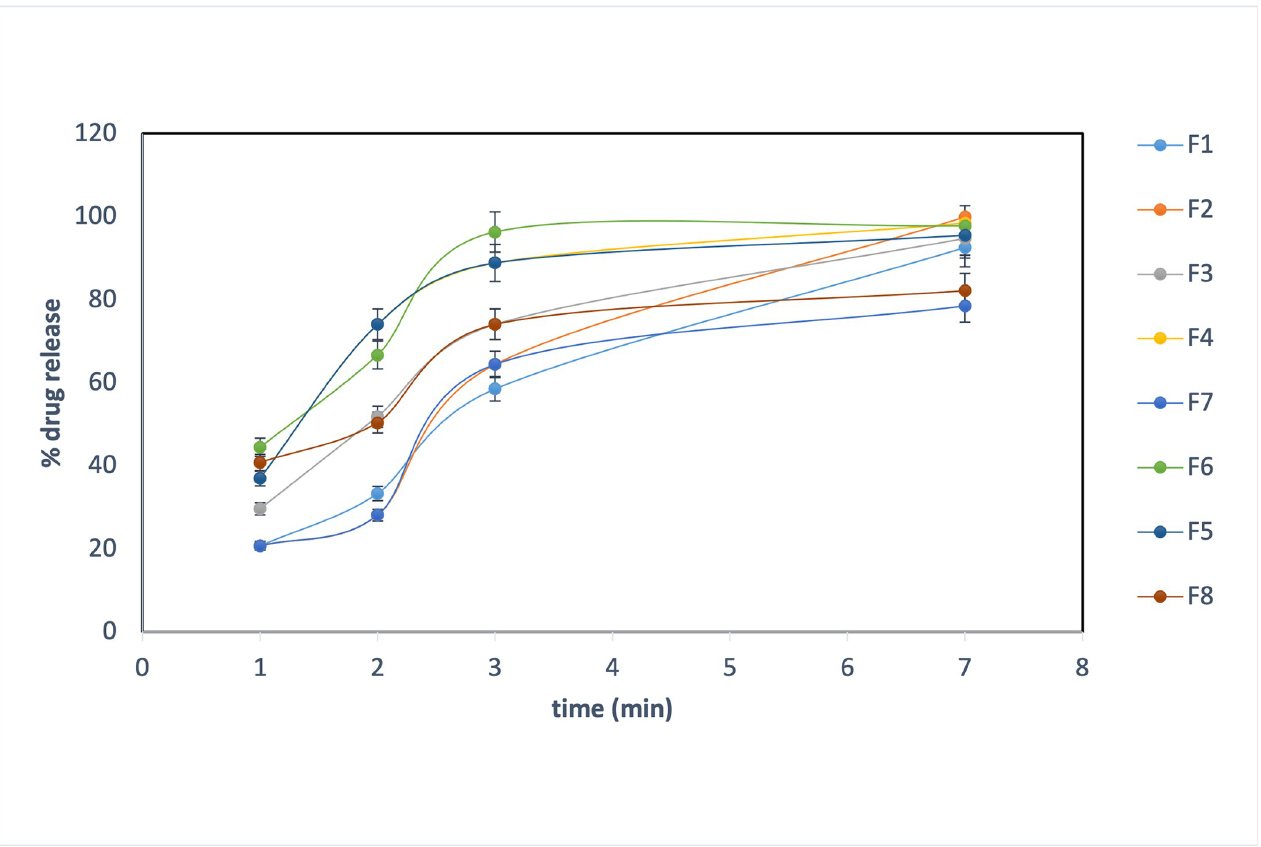
Fig 2. In vitro dissolution in phosphate buffer pH 6.8. F7 (2.5% gelatin and 5% propylene glycol) have the lowest percentage drug release within the first seven minutes (78.51%). The percentage of drug released within the first seven minutes from F2, F6, and F2 and formula containing 10% propylene glycol shows higher drug release than other formula (97.7%, 98.52% 99.99%, respectively).